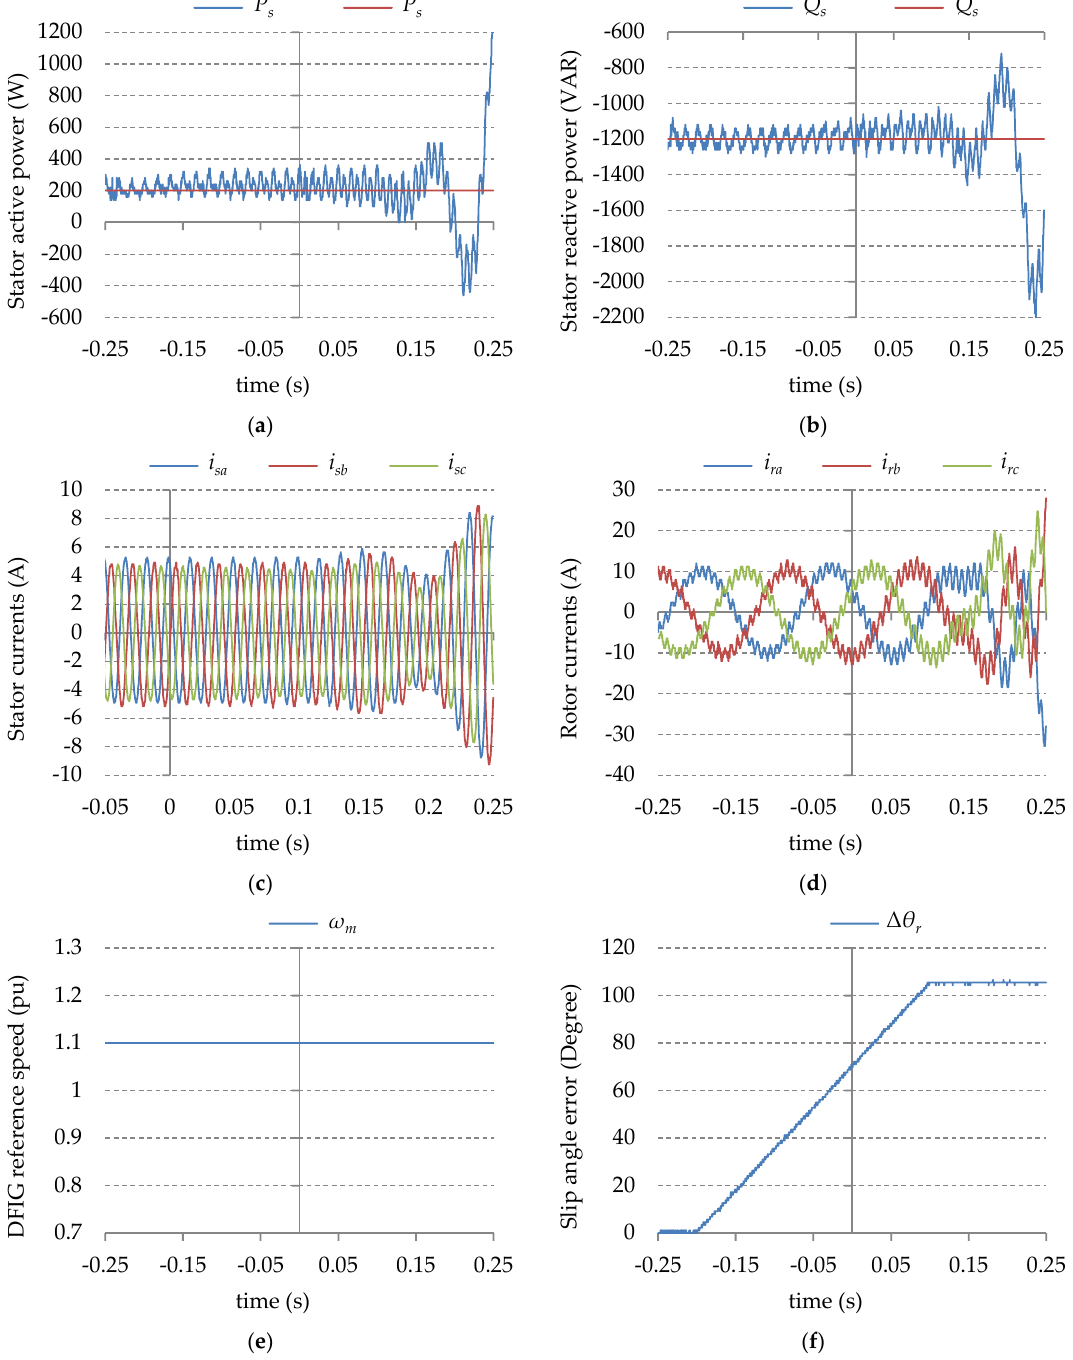
Figure 14. Experimental results for the effect of slip angle error on the proposed decoupled control: ( a ) stator active power; ( b ) stator reactive power; ( c ) stator currents; ( d ) rotor currents; ( e ) DFIG’s reference speed; ( f ) slip angle error.